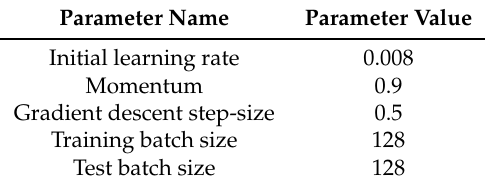
Table 6. Parameters settings of improved 2D LeNet-5 network and improved 1D LeNet-5 network.